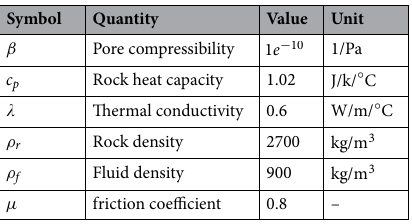
Table 1. Fluid and rock parameters used in the numerical